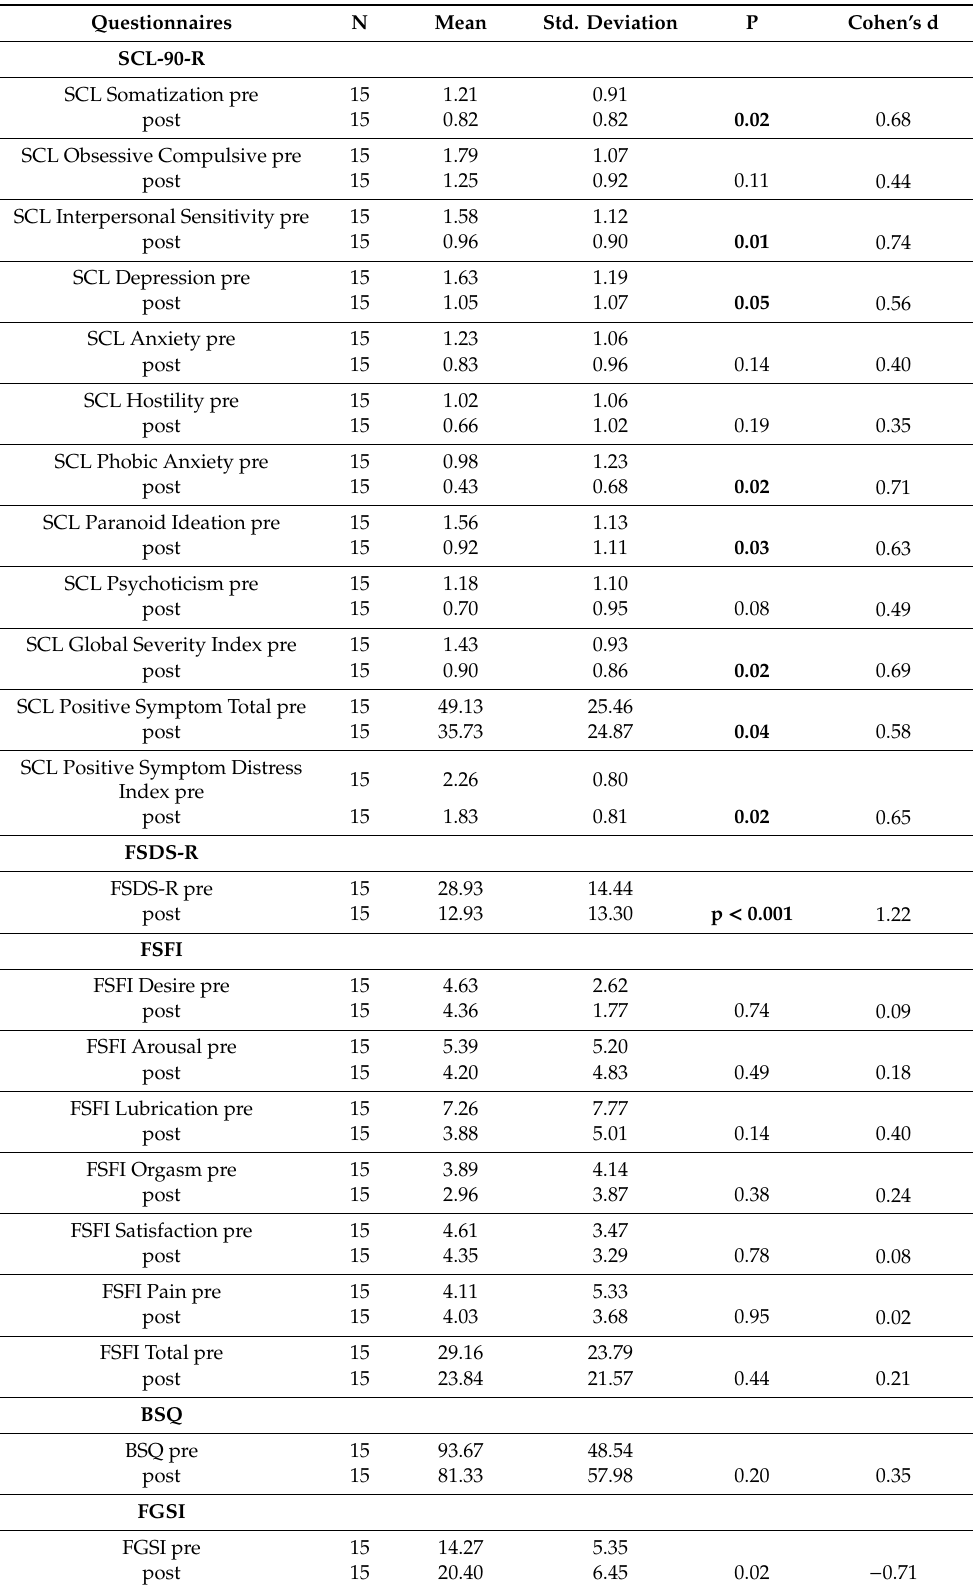
Table 3. Comparison between baseline measures (pre) and post-operative measures (one year, post) with regard to psychological well-being, sexual distress, sexual function, body image and genital self-image in women who su ff ered FGM /